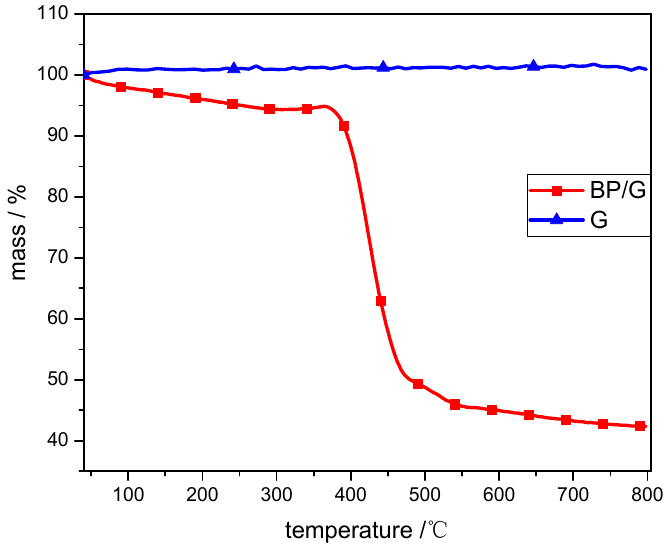
Figure 6. TG image of BP/G composite material and graphene, indicating the BP accounts of 58% of the BP/G composite material. Table 1. Additive amount of BP/G in BP/G/WPU membrane.